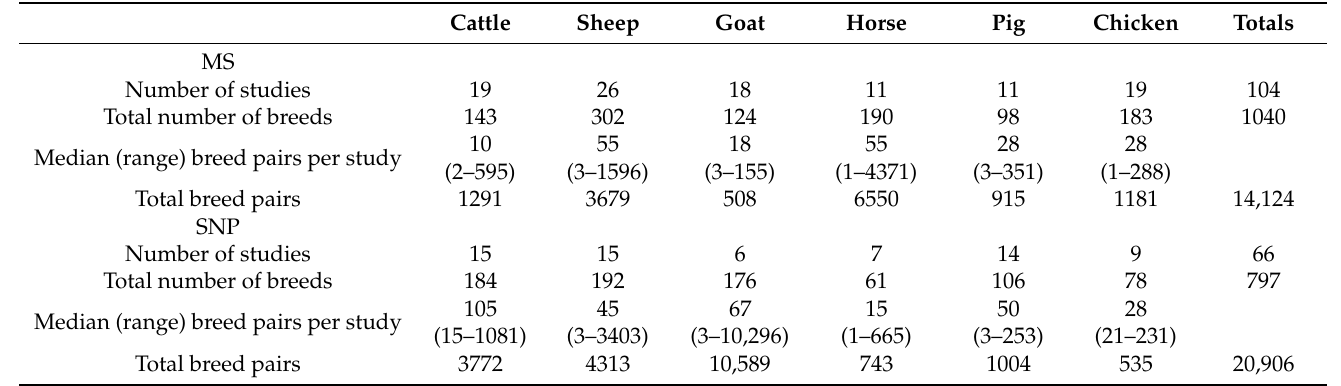
Table 4. Summary of studies from which F st data were extracted, according to species and methodology.